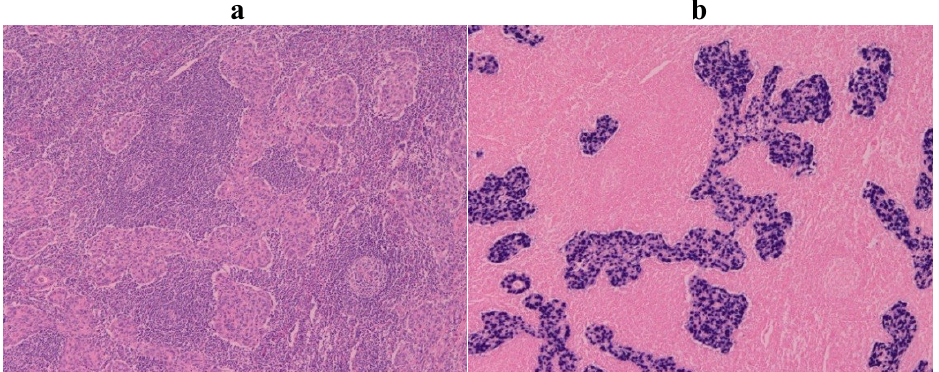
Figure 1. Lymphoepithelioma-like subtype of Epstein-Barr virus (EBV)-associated gastric carcinoma. ( a ) H & E staining; ( b ) EBV-encoded small ribonucleic acid 1 (EBER1) in situ hybridization demonstrates positive nuclei in the carcinoma cells, which are surrounded by infiltrating